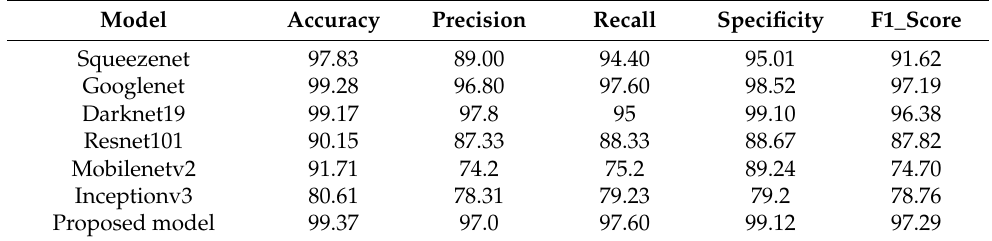
Table 15. COVID-19 five-class classification using ECG trace images comparison with state-of-the- art models.